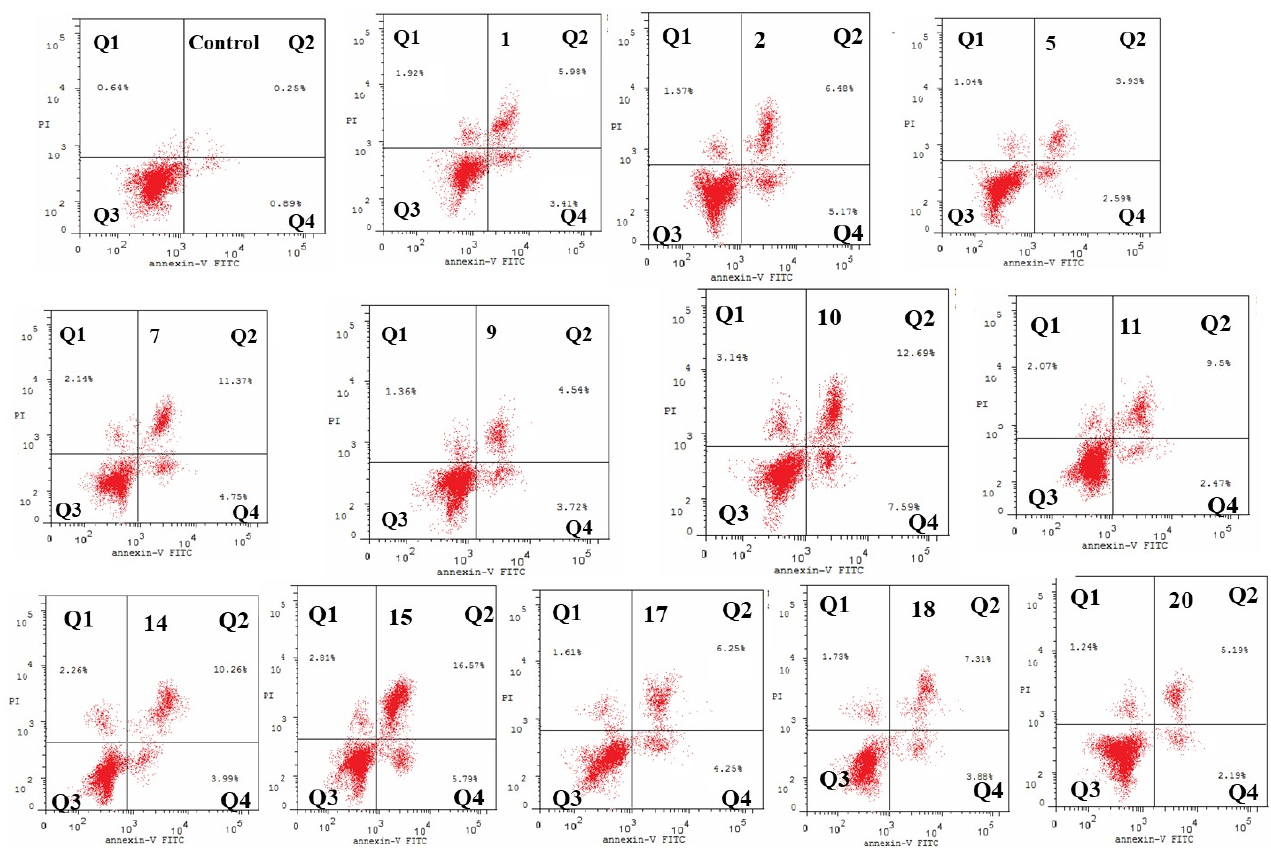
Figure 5. Dot plot representing four quadrant images observed by flow cytometry analysis. Q1: shows necrotic cells, Q2: shows later period apoptotic cells, Q3: shows normal cells and the Q4: shows early apoptotic cells. Table 5. Detection of different types of apoptotic cells induced in Caco-2 cells following treatment with parent compounds and their derivatives using annexin-V FITC/PI staining.